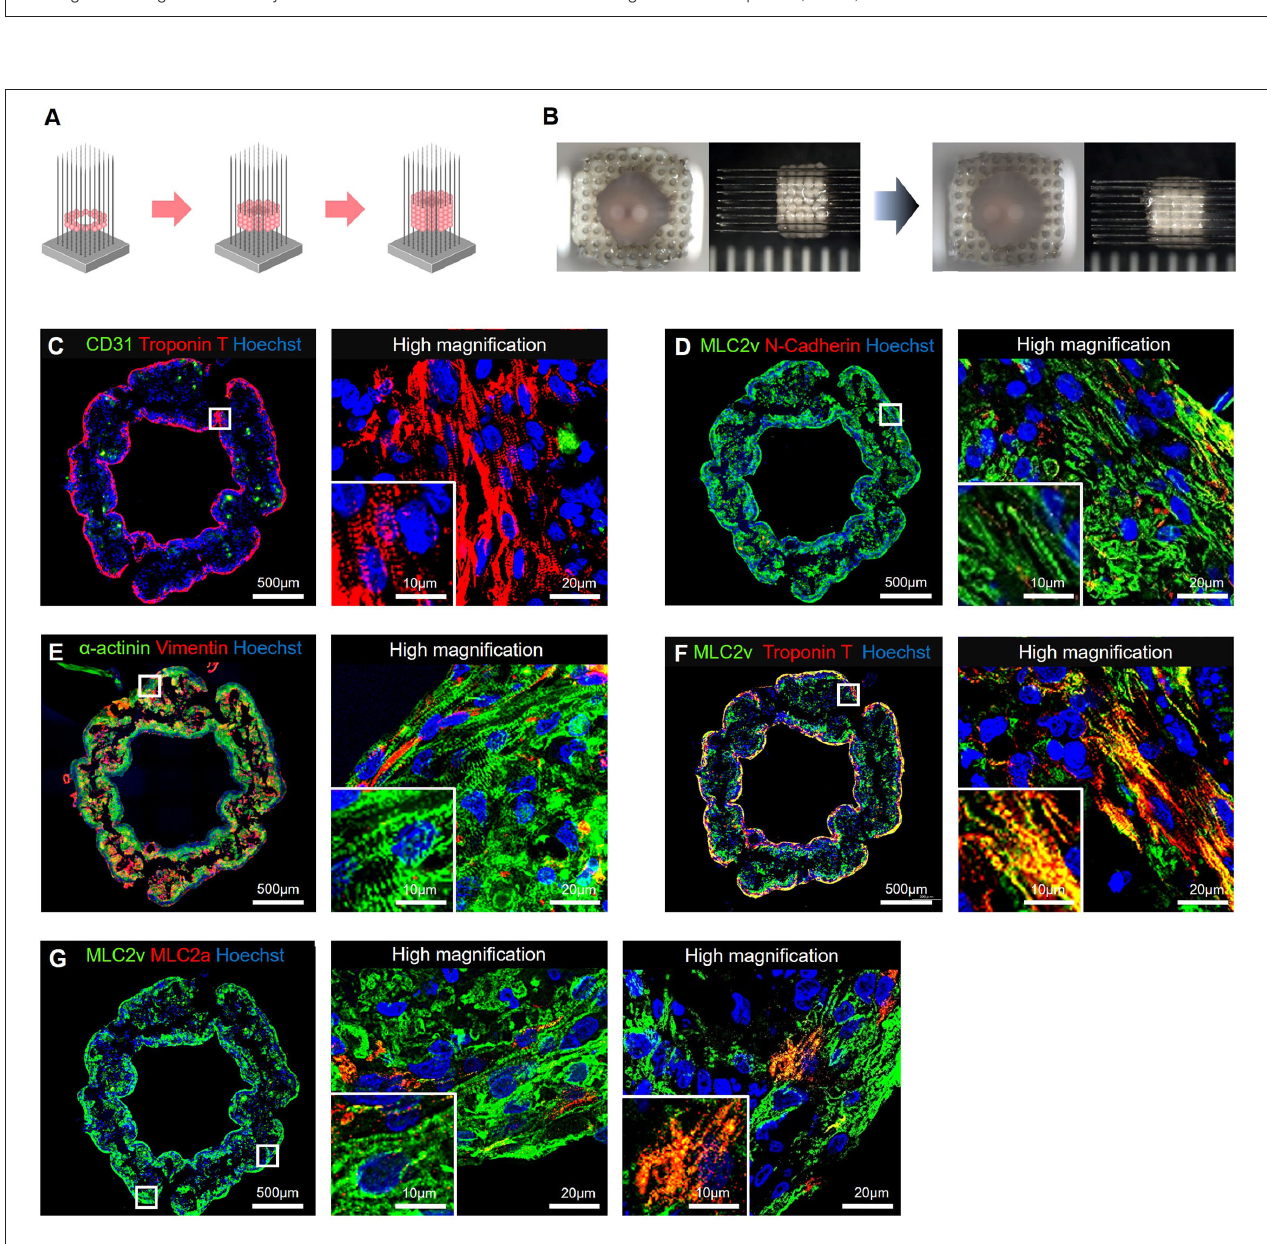
FIGURE 1 | of human induced pluripotent stem cell-derived cardiac organoids (hiPSC-COs). They are composed of hiPSC-CMs, human umbilical vein endothelial cells (HUVECs), and normal human dermal fibroblasts (NHDFs) seeded in four different ratios. The hiPSC-COs comprising 50% hiPSC-CMs, 25% HUVECs, and 25% NHDFs show a perfectly circular outline. (D) Beating rate and contraction analysis based on a fold change compared to the minimum area. The beating rate does not vary significantly among the four groups. The extent of contraction is maximum for the hiPSC-COs composed of 100% hiPSC-CMs. (E) Contraction of hiPSC-COs based on a fold change compared to the minimum area. The contraction is stronger in hiPSC-COs that are composed of a higher percentage of hiPSC-CMs. (F) Histological staining with hematoxylin and eosin and immunohistochemical staining for cardiac troponin T, CD31, and CD90.